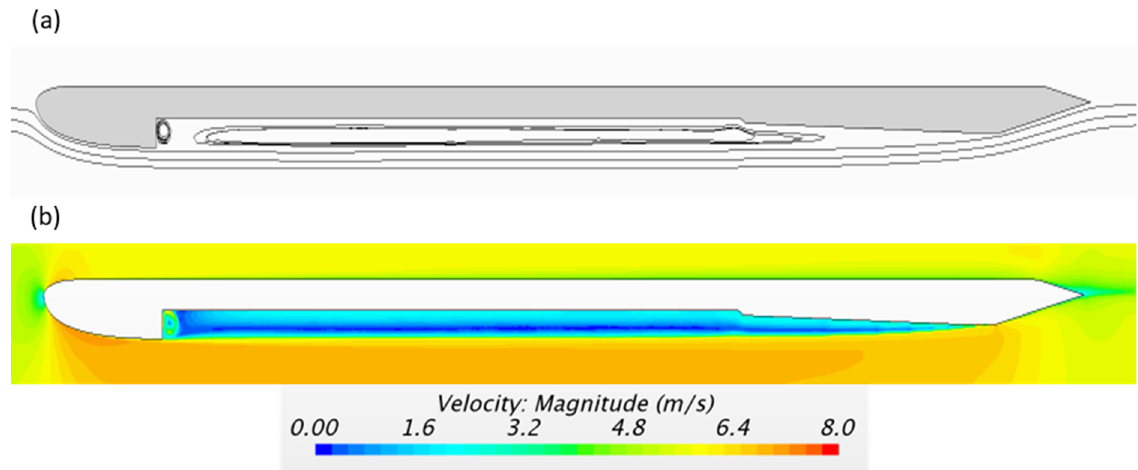
Figure 6. ( a ) Streamlines and ( b ) velocity magnitudes for numerical solution obtained on fine mesh at 𝑞 = 0.016 and 𝑈 = 5.4 m/s. Vertical dimensions are scaled up two times for clarity.